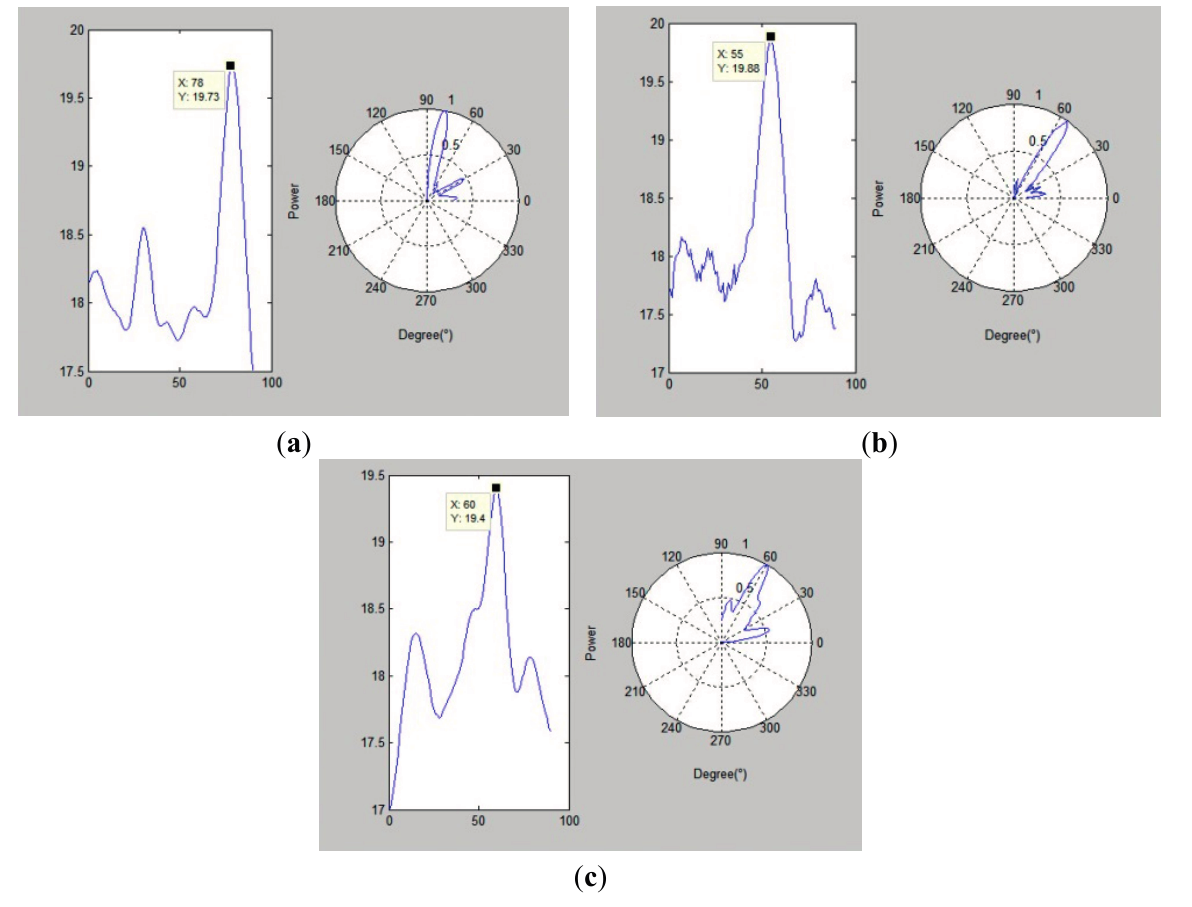
Figure 12. ( a ) Array position No.1; ( b ) Array position No.2; ( c ) Array position No.3.